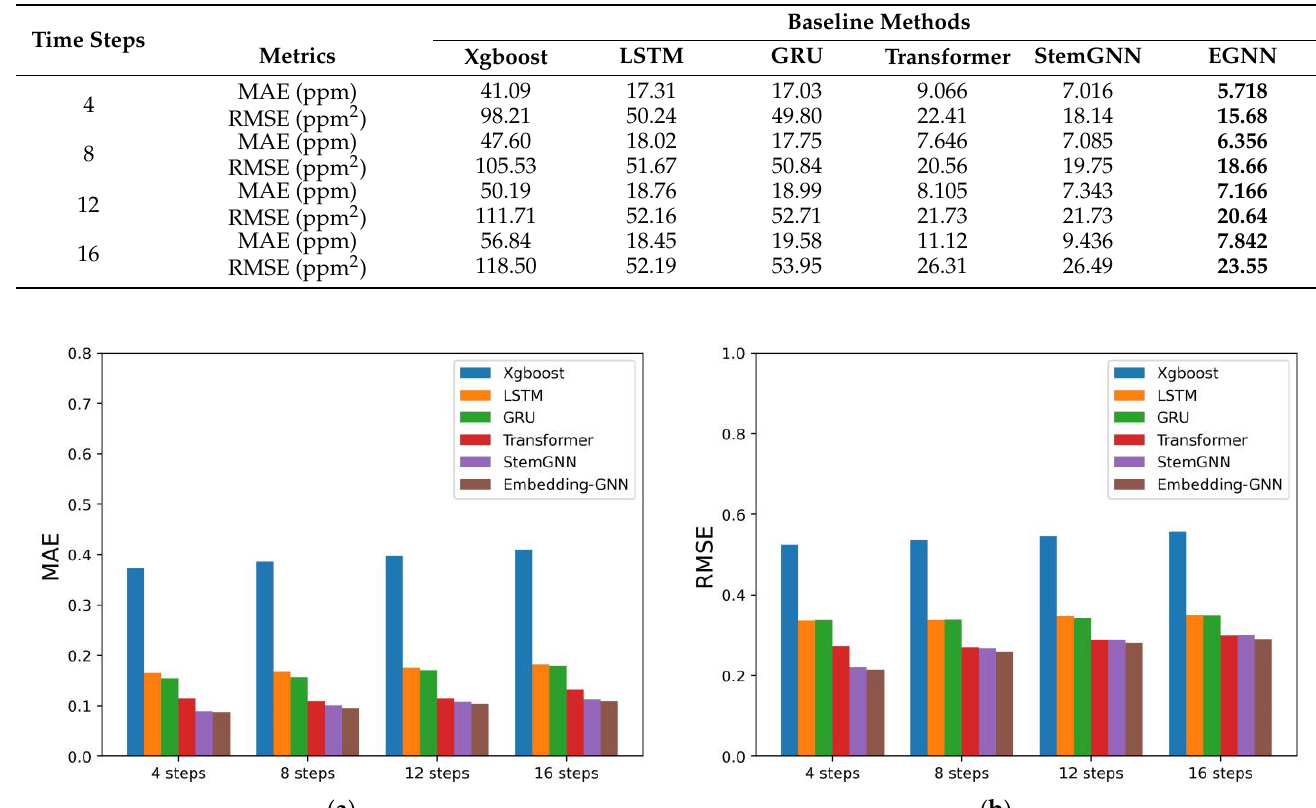
Table 5. Prediction results of different time steps based on EGNN and the other five baseline models.